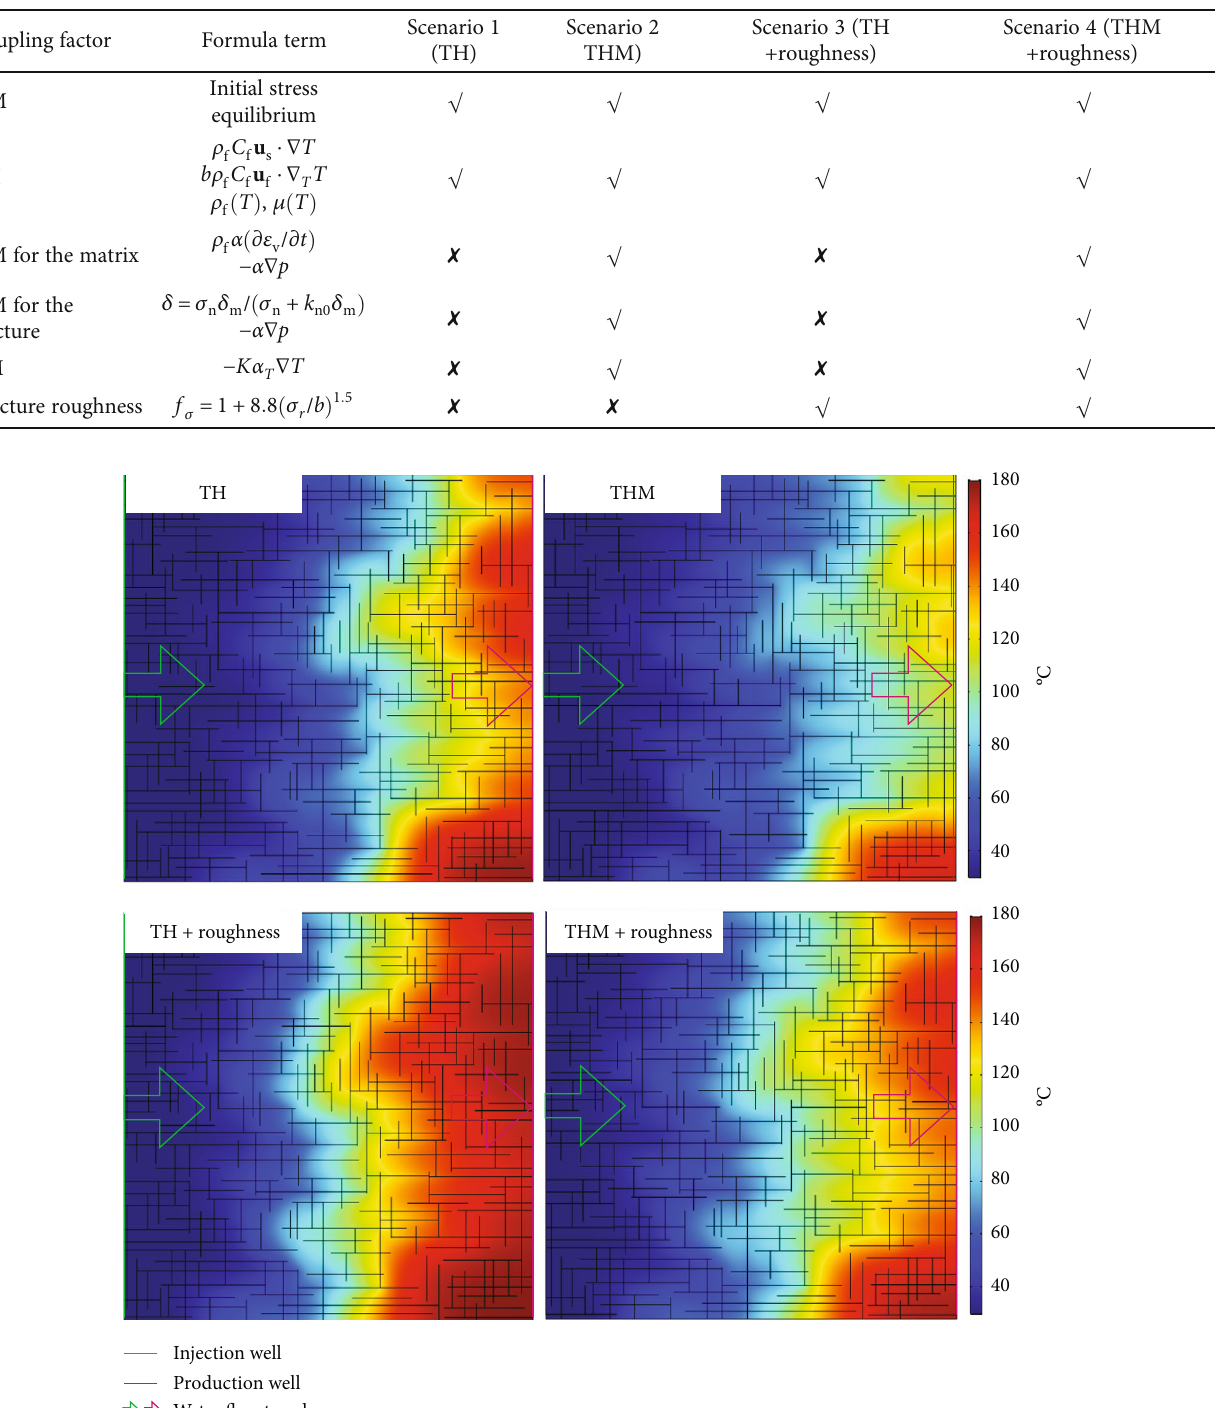
Table 3: Di ff erent coupling factors in four scenarios.